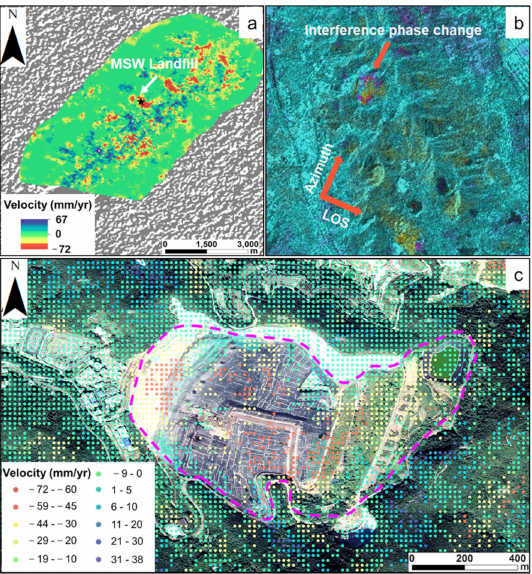
Figure 7. LOS deformation map from SBAS analysis: ( a ) deformation map for the surrounding area of the landfill, where the black pentagram indicates the landfill location; ( b ) phase change of interferogram; ( c ) deformation map of Tianziling landfill, where the purple dashed line indicates the landfill